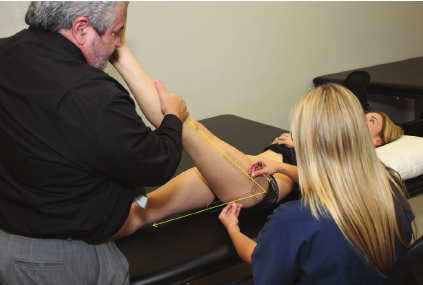
Figure2:Measurementofrangeduringpassivestraightlegraisetest was performed by trained examiners who were blinded to subject group